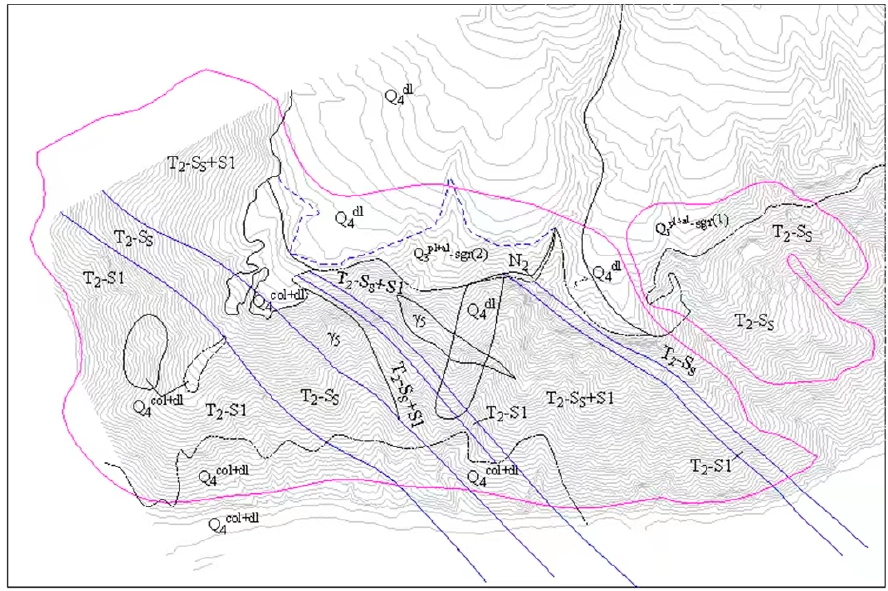
Figure 7. The lithology of the slope of the typical dumping body on the left bank.